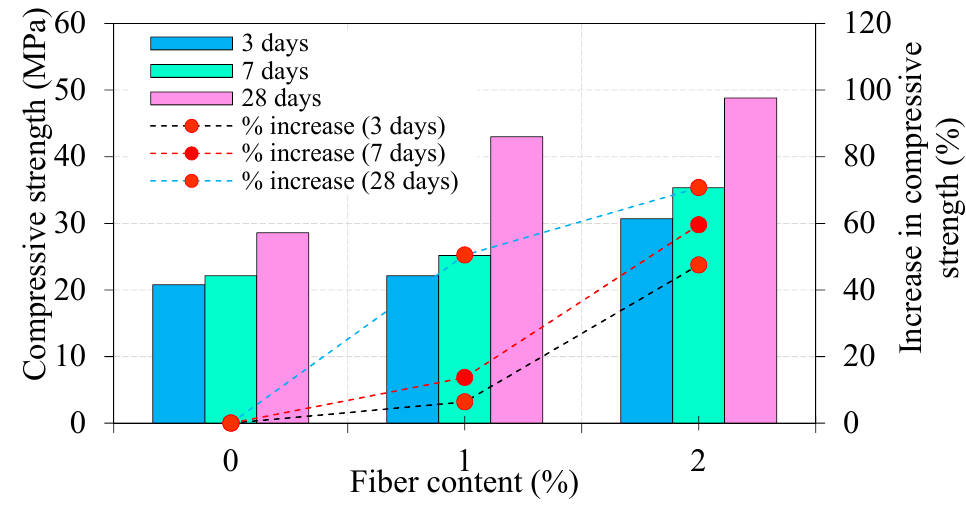
Figure 5. E ff ect of steel fiber content on the compressive strength of mortar. Figure 5. Effect of steel fiber content on the compressive strength of mortar.